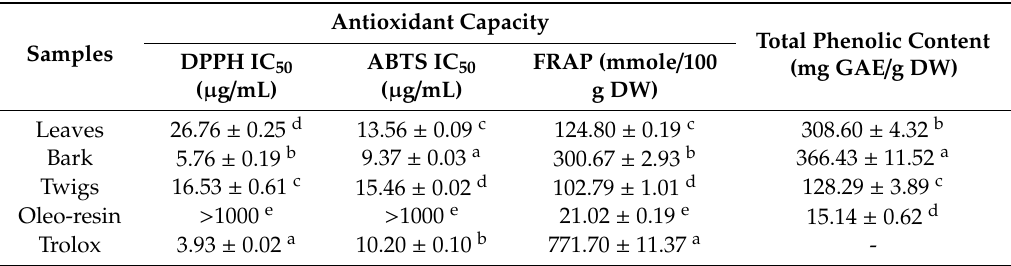
Table 5. Total phenolic content and radical scavenging activity of D. alatus leaf, bark and twig extracts, and